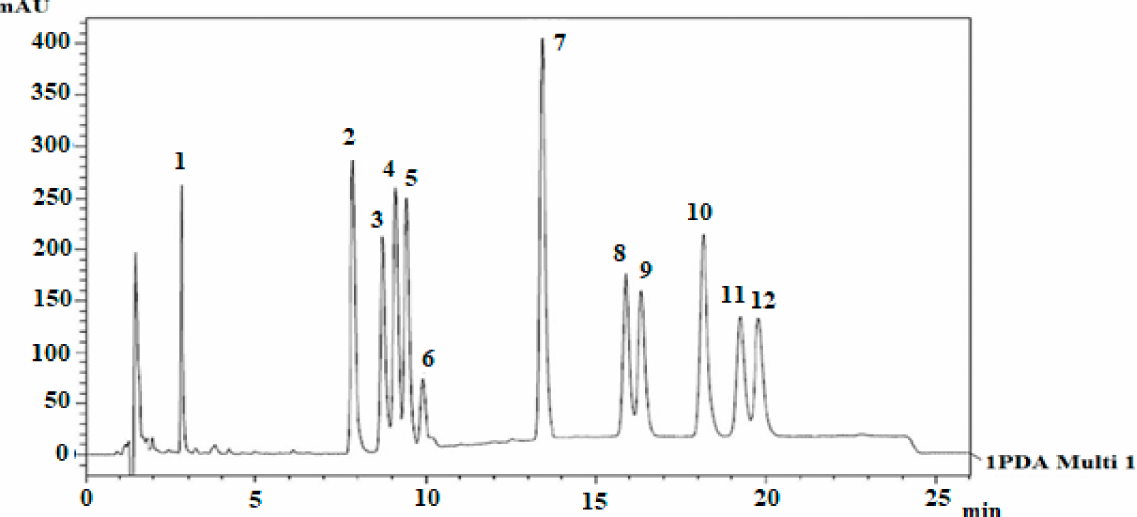
Figure 9. HPLC profile of 11 cannabinoids by using Luna C-18 analytical column [21]. Elution order: 1-I.S, 2-CBDA, 3-CBGA, 4-CBG, 5-CBD, 6-THCV, 7-CBN, 8-d9THC, 9-d8THC, 10-CBL, 11-CBC, and 12-THCA.Reprinted with permission from Ref. [21]. Copyright 2021 Copyright